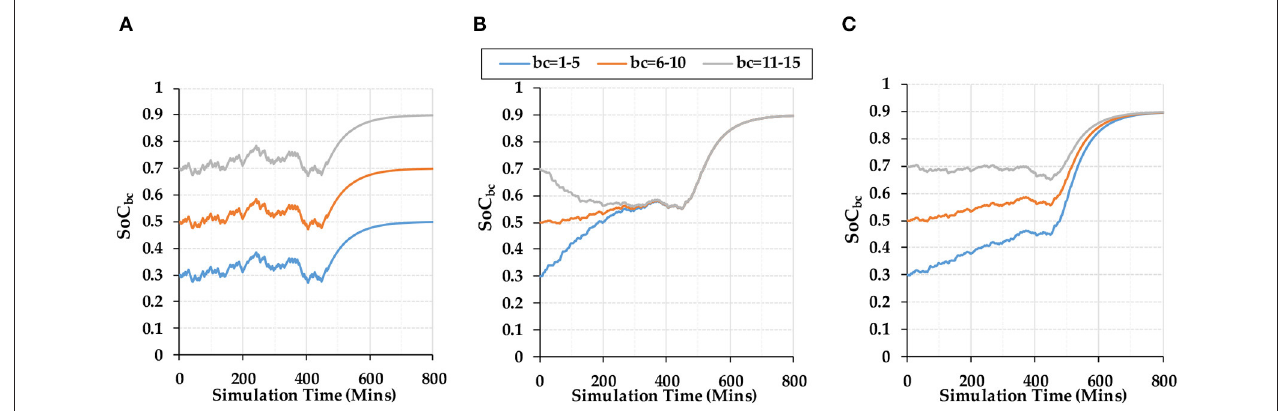
FIGURE 6 | SOC outputs of Sc-1 (A) , Sc-2 (B) , and Sc-3 (C) in the first 800min.